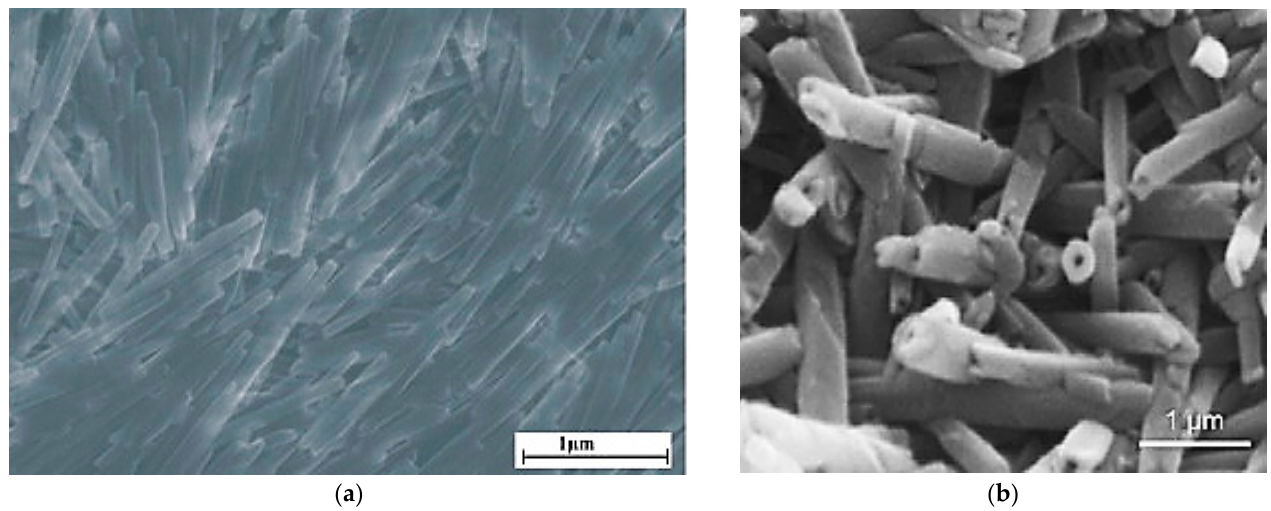
Figure 2. ( a , b ) Scanning electron microscope (SEM) images of tubular halloysite mineral on a thin surface section [11] and on a fractured one [12], respectively.